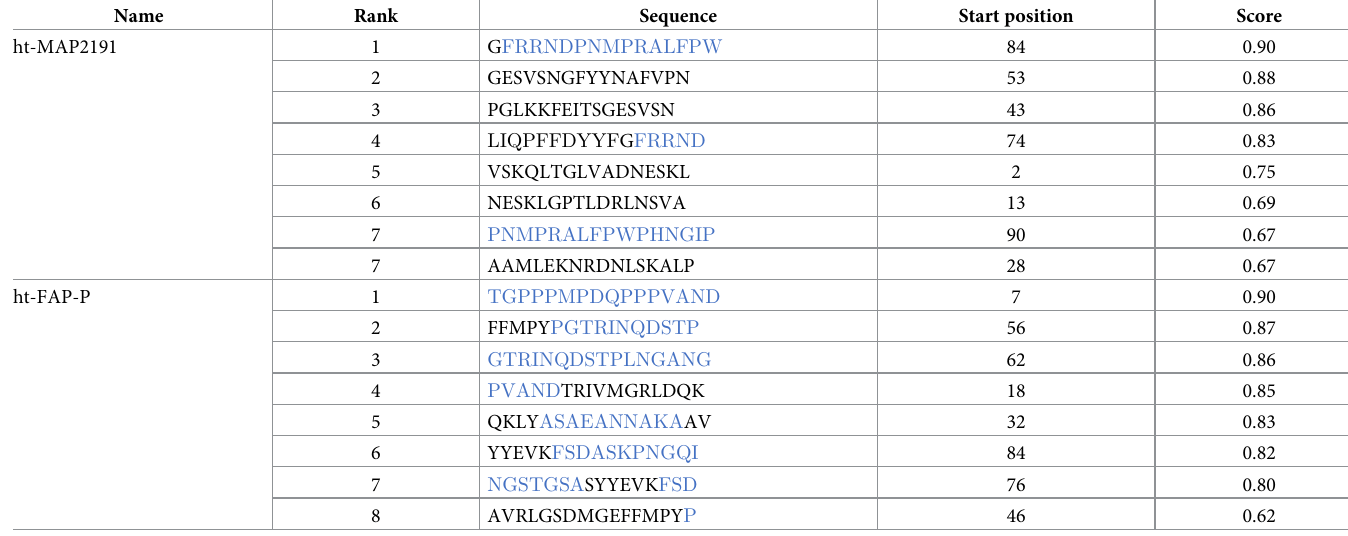
Table 4. LBL epitopes of constructs predicted by ABCPred server. Common residues detected by both ABCPred and BepiPred servers are marked in blue.